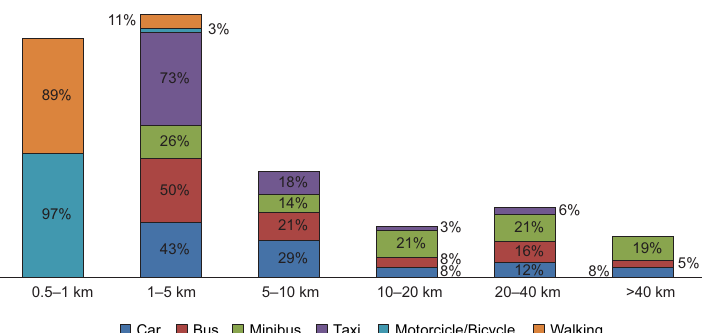
Fig. 7. Travel distance based on the type of transportation in the city of Pristina.